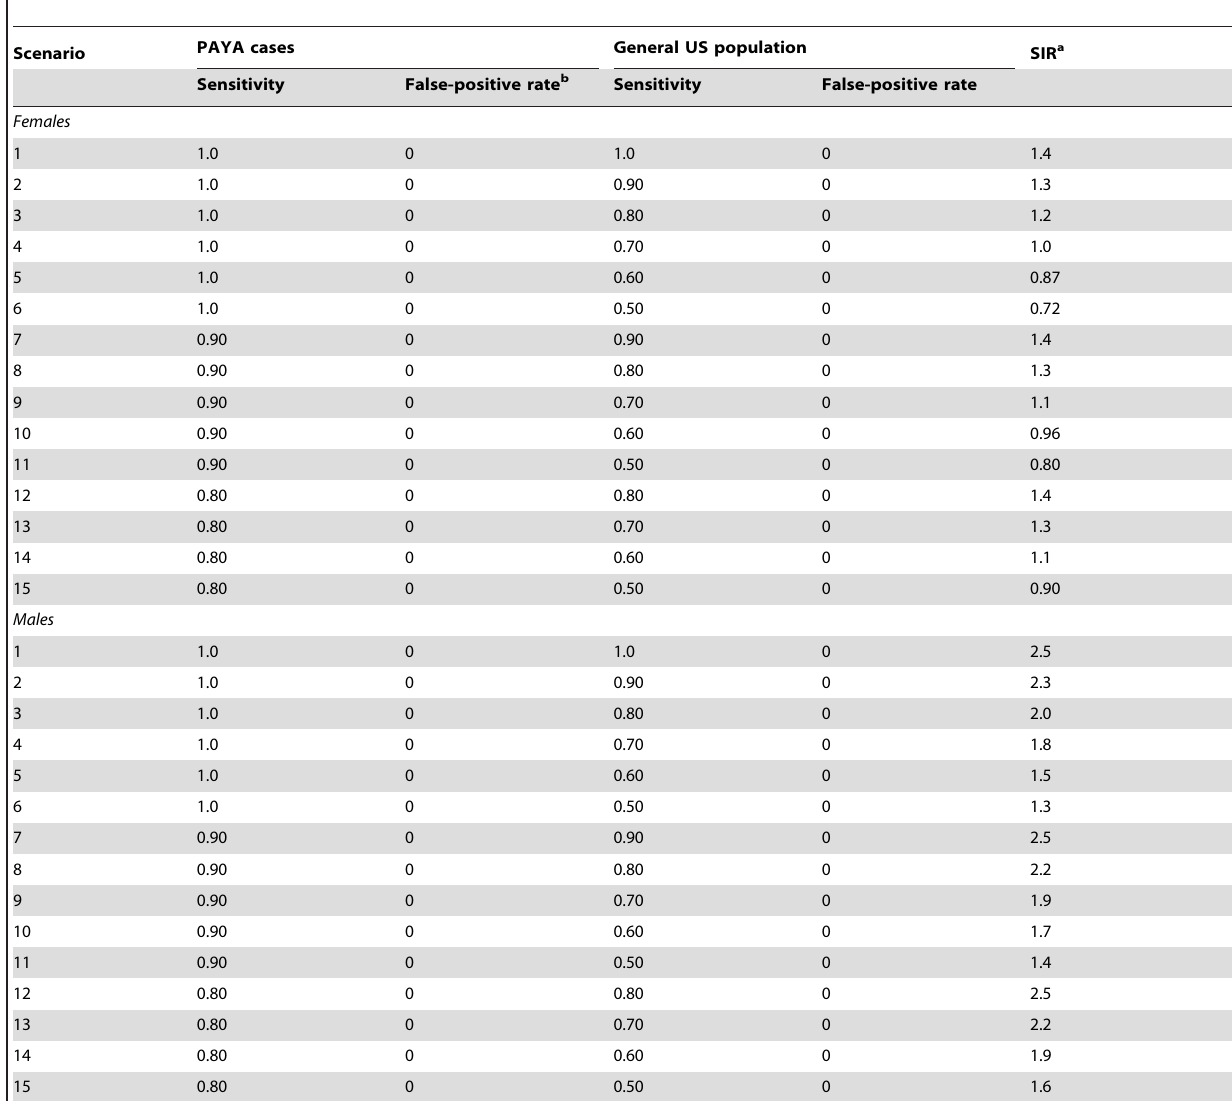
Table 4. Assessment of sensitivity to potential outcome misclassification when estimating the relative excess of HPV-associated malignancies among pediatric and young adult (PAYA) cancer survivors compared with the general United States (US)